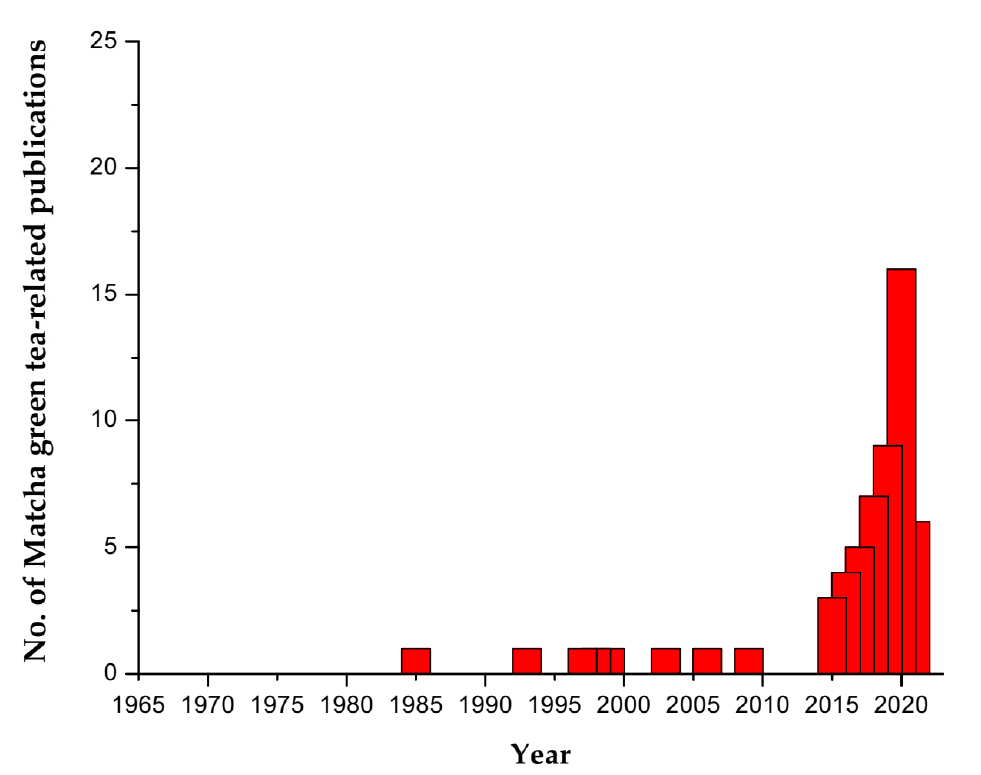
Figure 4. Graph showing results of PubMed search on matcha-based publications.